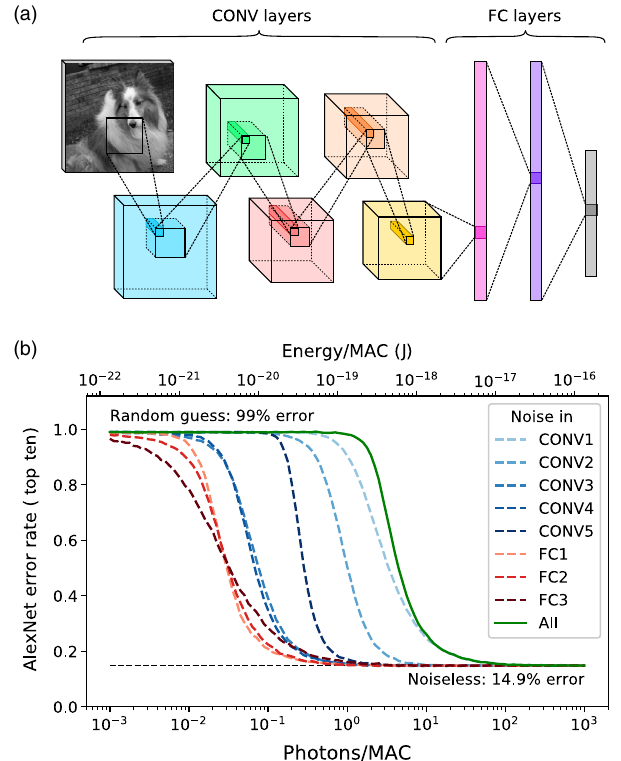
FIG. 8. (a) Schematic drawing of ALEXNET , which consists of five convolutional layers and 3 fully connected layers. Pooling and normalization steps not shown. (b) Error rate for pretrained ALEXNET as a function of n MAC . Dashed lines show the effect of noise in a single layer, while solid green line shows the performance of the actual machine where all layers have